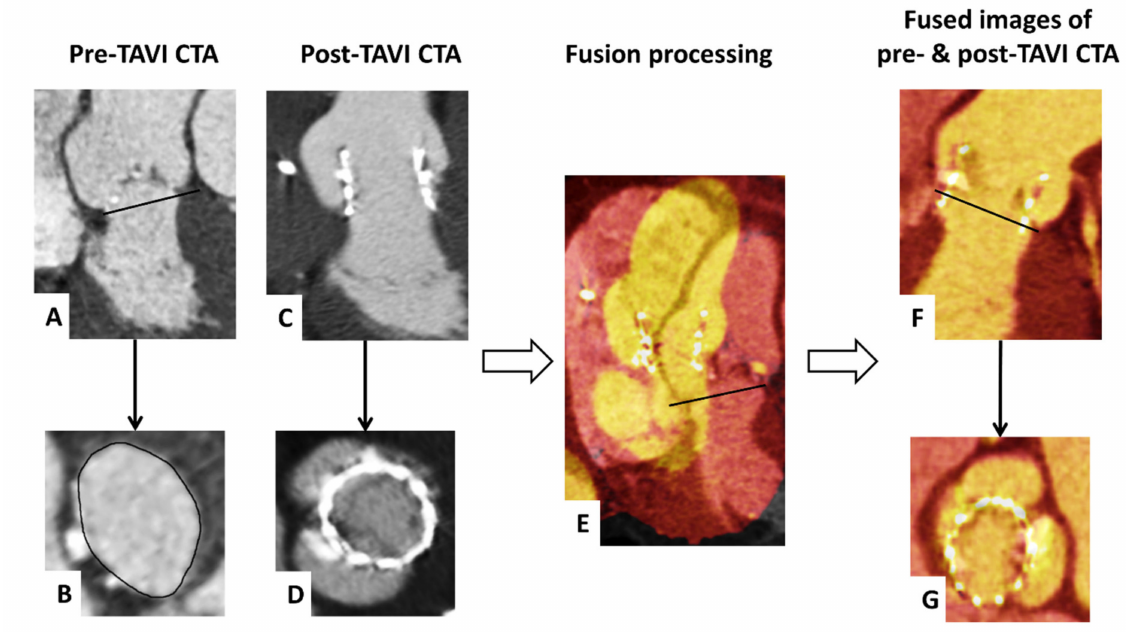
Figure 2. Visualization of fusion imaging of pre- and post-TAVI CTA. CTA axial and sagittal oblique reconstructions show the pre-TAVI images with delineating of the annulus plane ( A , B ) and post-TAVI images with the implanted Sapien 3 ( C , D ). Subsequently, the pre- and post-TAVI images were semi-automatically merged ( E ). Finally, the fused images were manually adapted to achieve an optimal alignment of the annular region in all reconstructions ( F , G ).